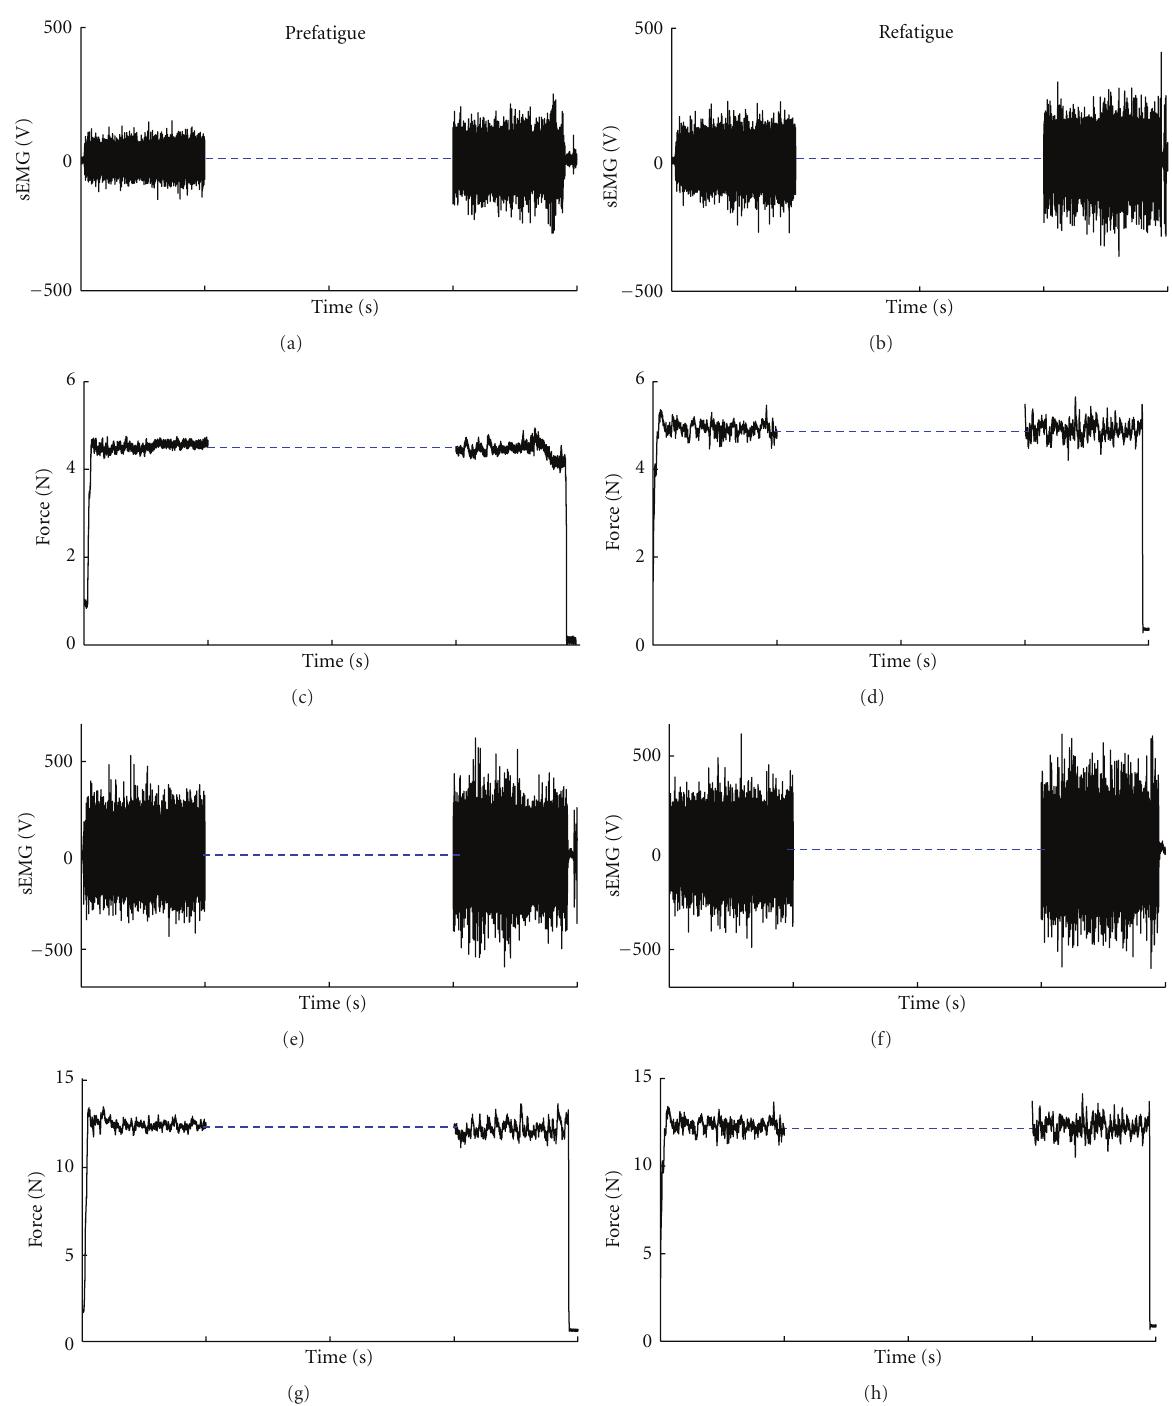
Figure 1: Examples of sEMG signals and the forces recorded during the prefatigue and refatigue tasks until exhaustion for the two types of treatments. (a)–(d) Passive rest therapy, (e)–(h) Active LEDT.